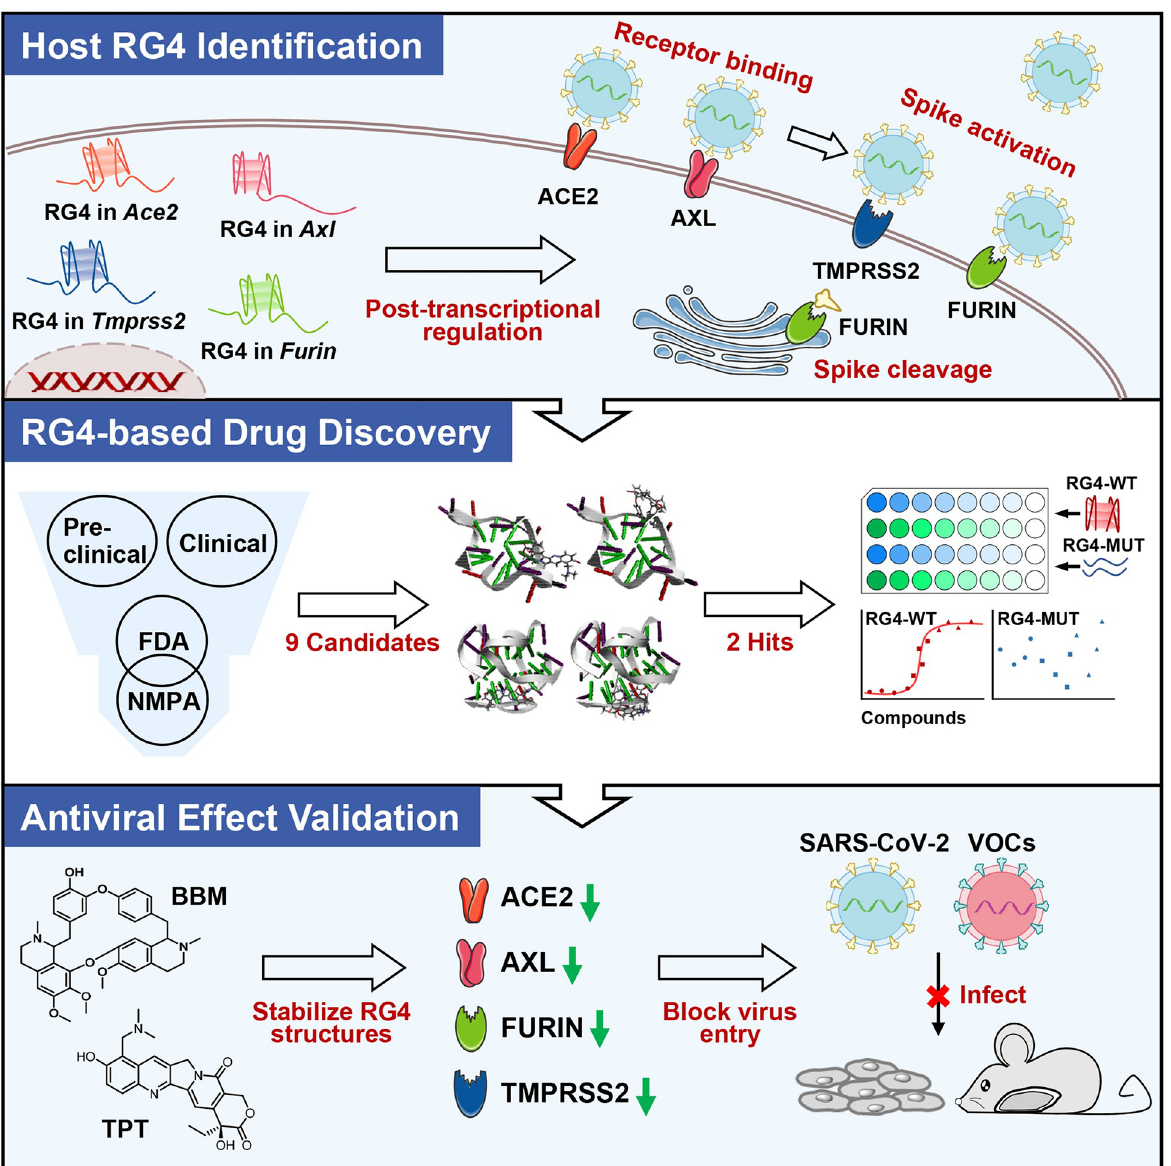
Fig 6. A schematic model of this article. Topotecan and Berbamine may block SARS-CoV-2 infection by suppressing RG4-containing host factors. Fig 6 was created using Microsoft PowerPoint and Adobe Illustrator.